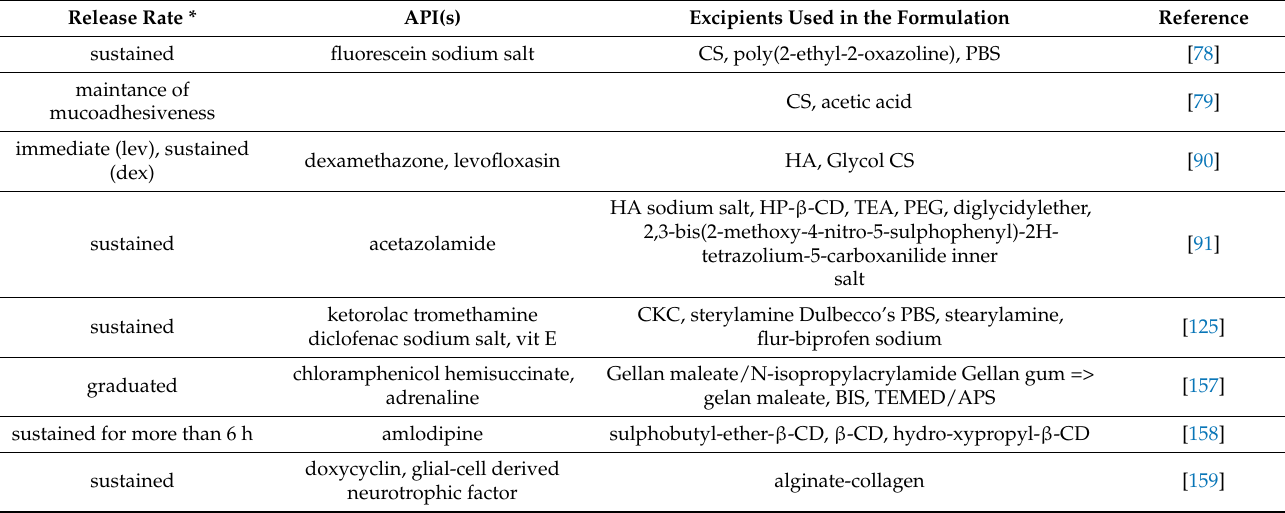
Table 3. An overview of the excipients used in modified release ocular formulations